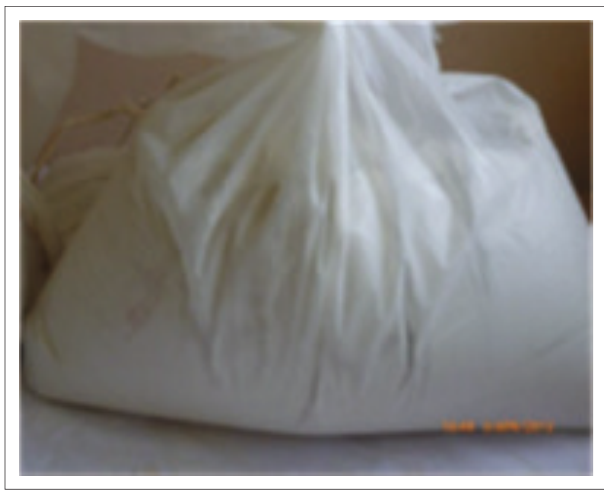
FIGURE 8: A Bag of plaster of Paris (POP) powder.